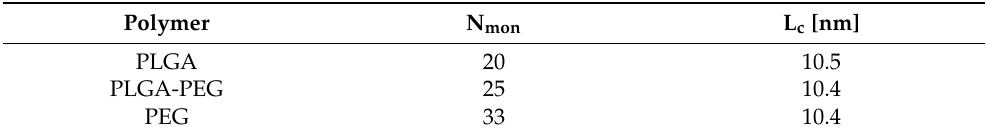
Figure 1. Layout of ( A ) the experimental design implemented in this study and ( B ) the progression of each simulation, where all oligomers in the simulation box are restrained to the same R g value corresponding to a certain level of extension. Table 1. The monomer length (N mon ) and contour length (L c ) of the 3 oligomers, for each polymer type, simulated in this study. Each PLGA-PEG oligomer consisted of N LGA = 12 and N EG = 13. This was performed to ensure that the simulated oligomers were still diblock copolymers with a nearly 1:1 LGA:EG ratio at the given contour